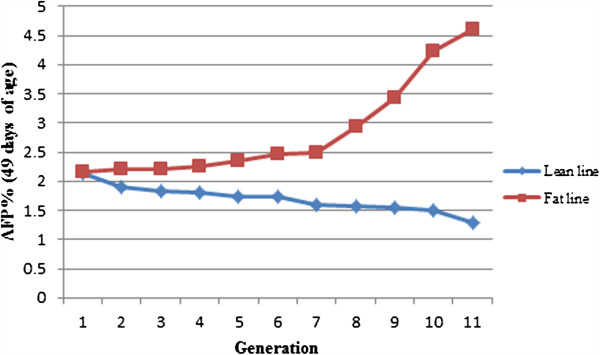
The separation of AFP over 11 generations between lean and fat lines.